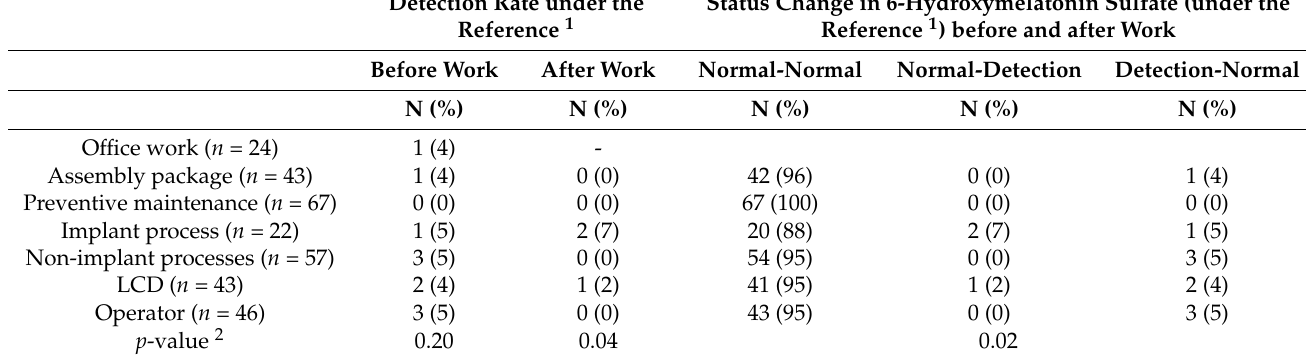
Table 3. Detection rate and the status change in the urinary 6-hydroxymelatonin sulfate levels under the reference according to job category.